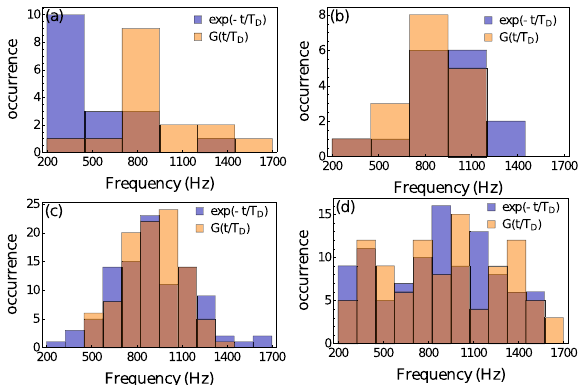
Fig. 5 Root-mean-square error ratio between local optimisation for power-law and exponential model fi ttings. The ratio is plotted as a function of the frequency δ and the noise bandwidth de fi ned by T D . Each dot is calculated with the rmse of histograms as those shown in Fig. 4. Black squares show experimental results. Orange circles display the ratio for data generated with power-law decay while blue stars correspond to data generated with exponential decay. Solid lines show the mean ratio for all dots while shaded areas correspond to the standard deviation for each mean. Note that experiment six in Supplementary Table 1 is not shown but it is considered for the mean